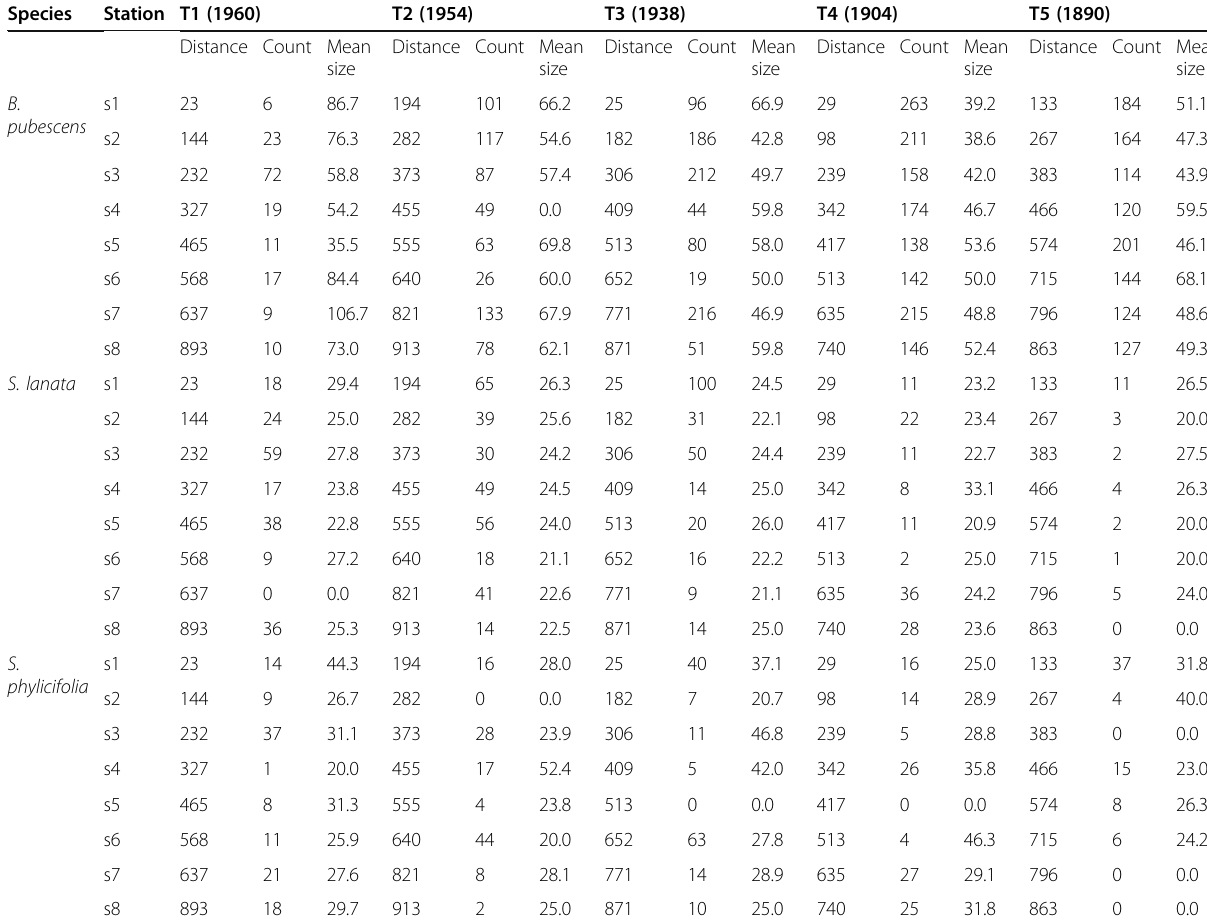
Table 1 Summary of data collected for this study